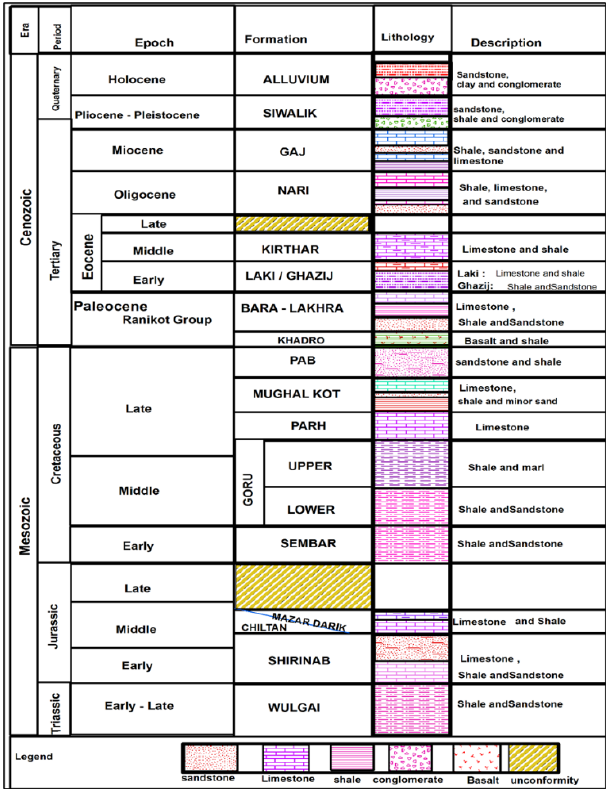
Figure 2: Showing Stratigraphy of Southern Indus Basin Pakistan (Shah, 1977; Raza et al.,